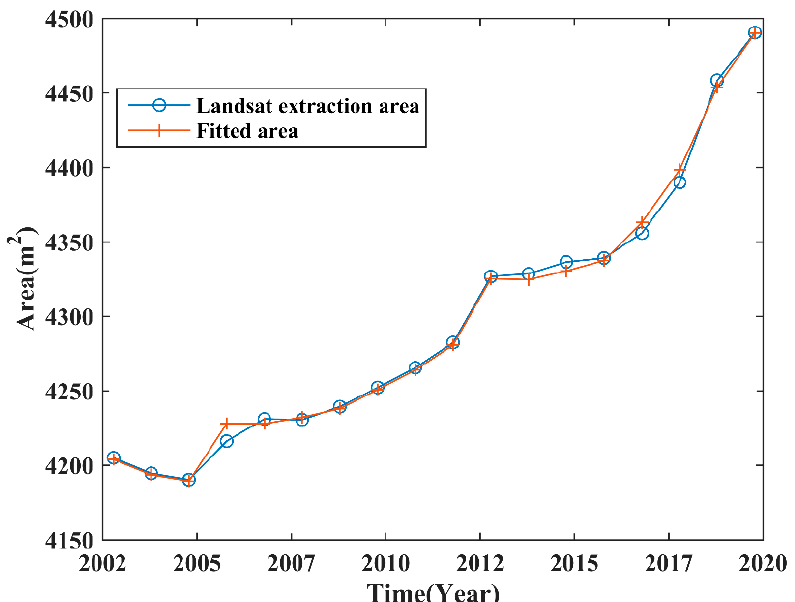
Figure 15. Comparison between Landsat extracted area and fi tt ed area using water level–area for-